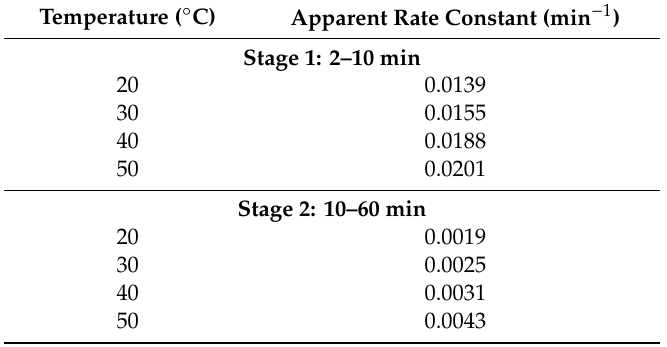
Table 3. Value of apparent rate constant for ash diffusion control model in two leaching stages.